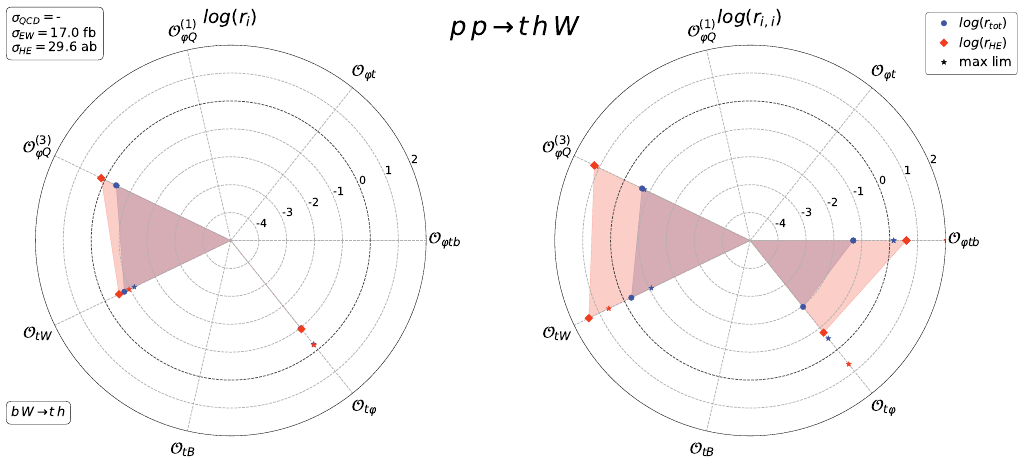
Figure 16. Radar plot for the process p p of the main text for a detailed